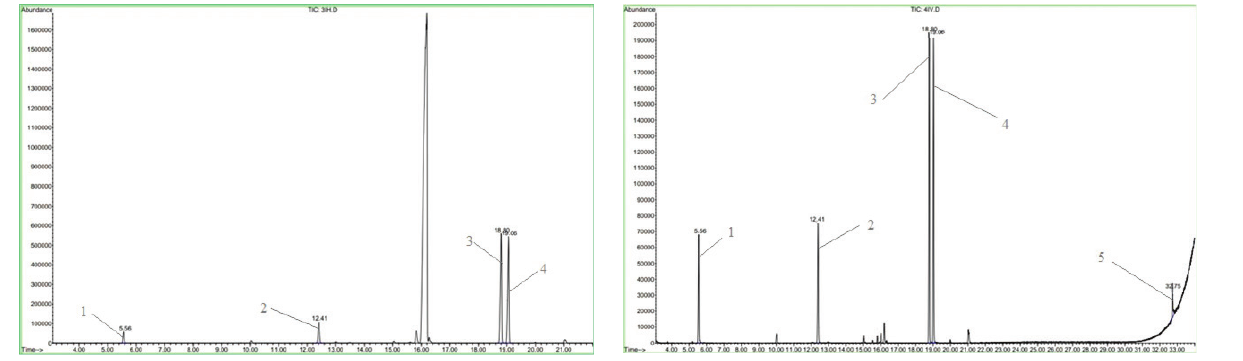
Figure 4. Chromatogram of free carbohydrates in the herbal mixture No. 4 (1 – arabinose, internal standard; 2 – glucose; 3–4 – fructose; 5 – sucrose).